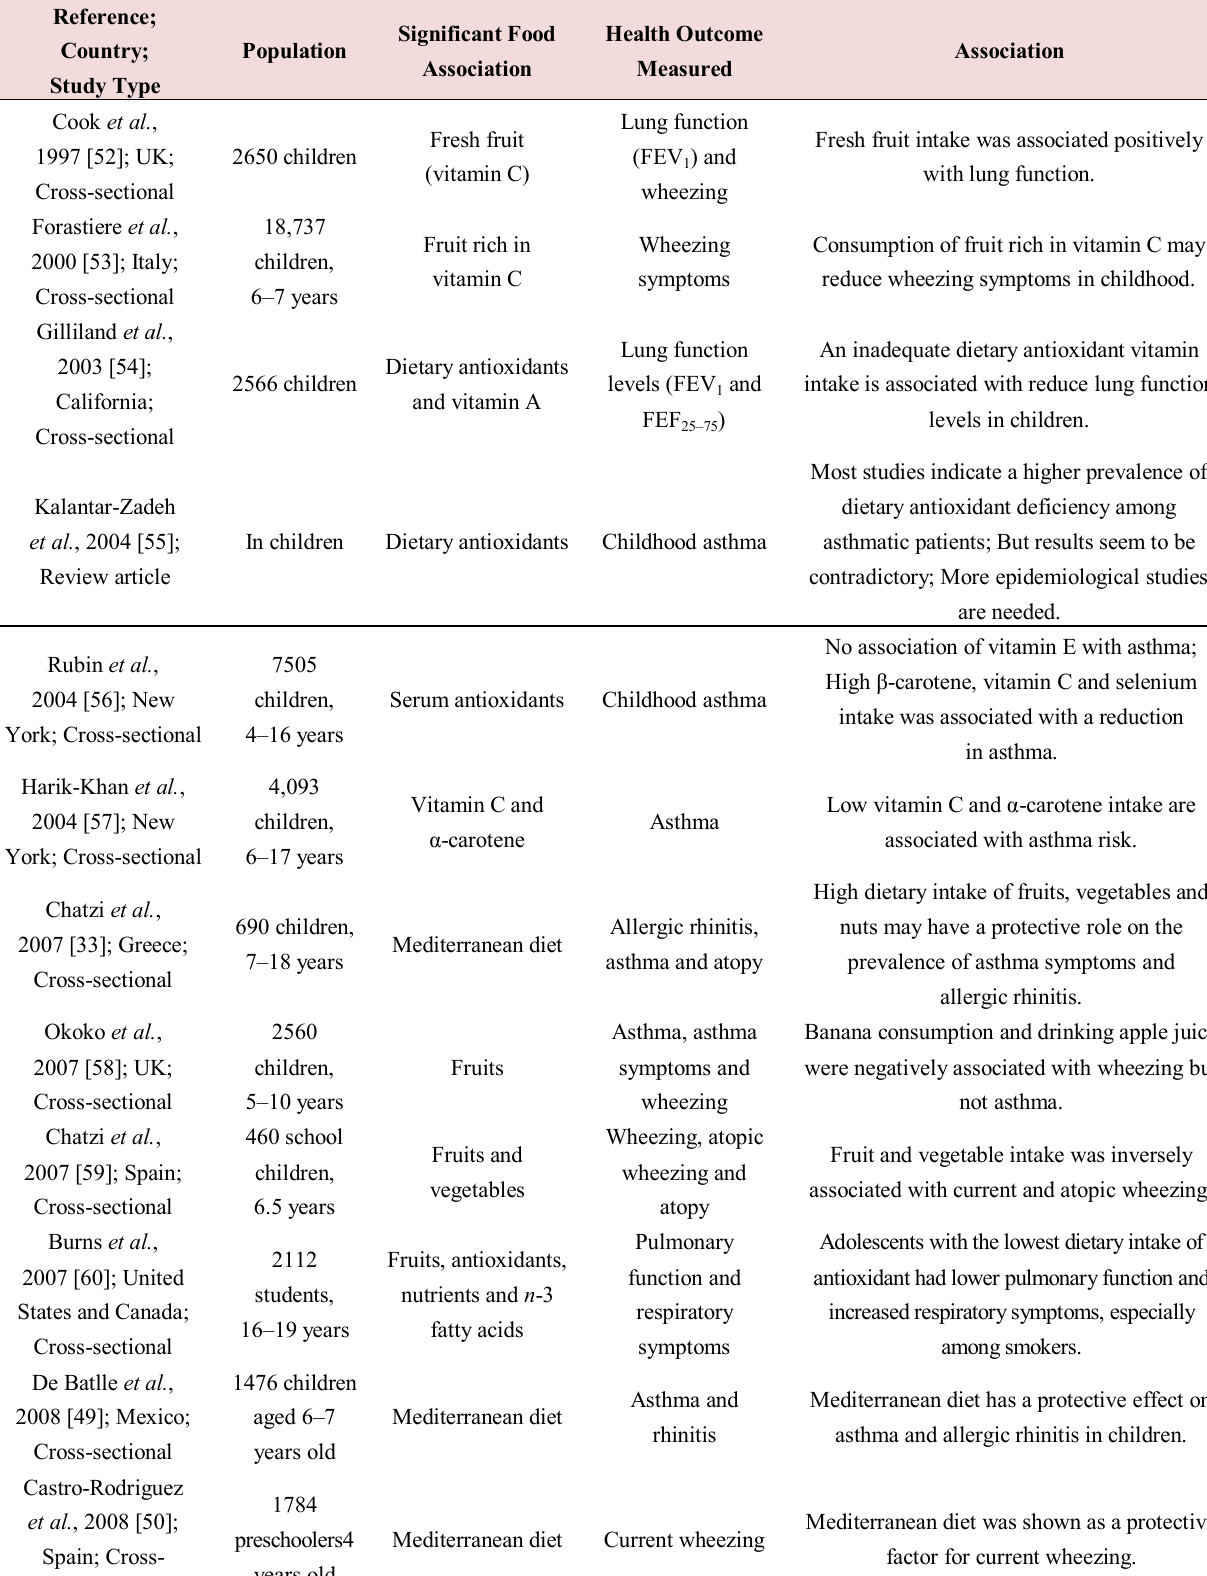
Table 2. Reviewed studies on antioxidant nutrients, vitamins, and Mediterranean diet in children and adolescents and their association with allergic